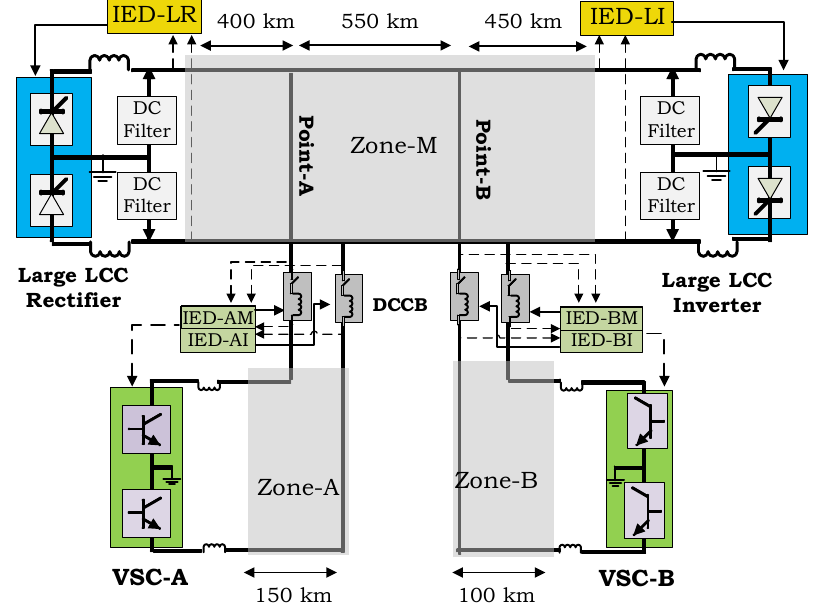
Figure 2. Hybrid VSC-LCC transmission system with two VSCs connected to an LCC-HVdc link. Two VSC stations with a lower rating compared to the LCC stations are connected through two transmission lines, which are hereafter referred to as VSC branches, to a 1400 km long